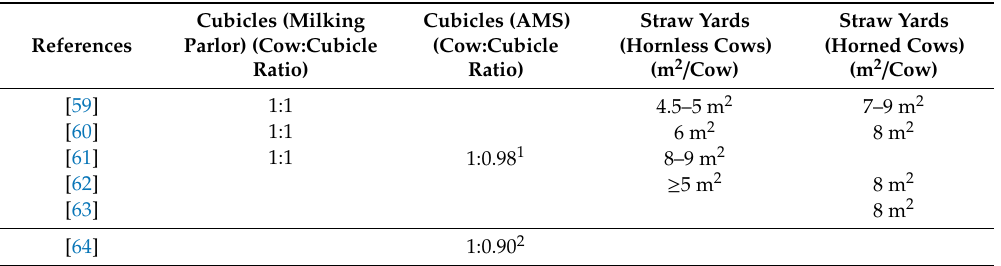
Table A2. Lying space—recommendations for herds with a milking parlor or automatic milking system (AMS) and with horned or hornless cows.